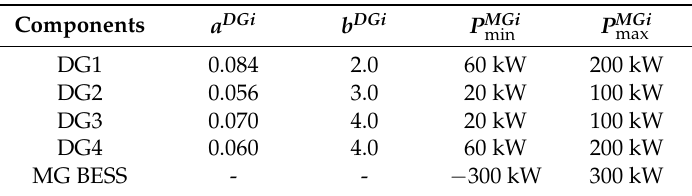
Table 2. Parameters of the DGs in the